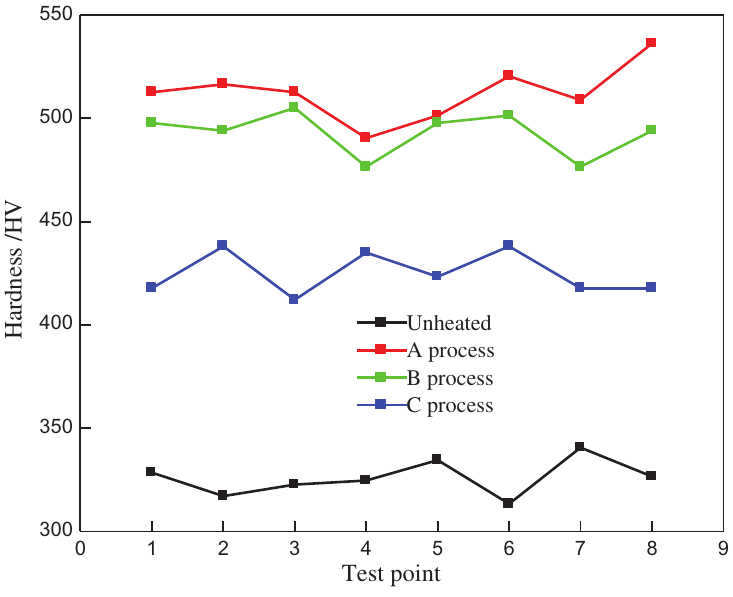
Figure 5: The curve of hardness distribution on the X-Y surface of Inconel 718